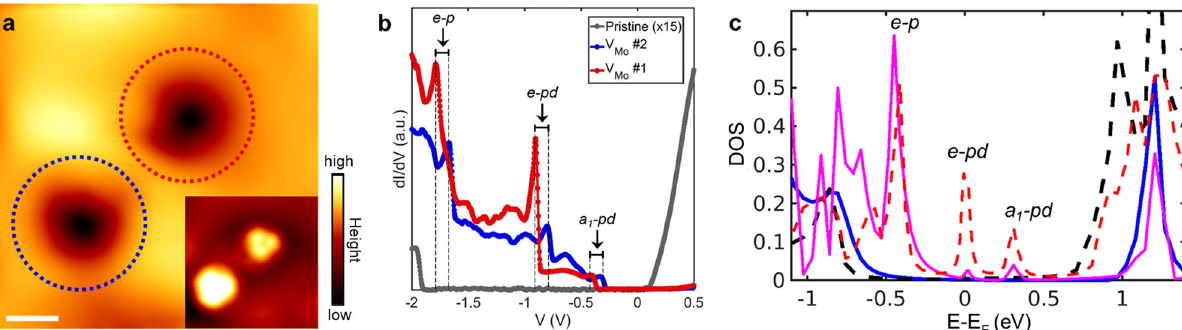
Fig. 2 Localized in-gap states exhibited by molybdenum vacancies. a STM topography zoomed in on the two primary defects shown in Fig.1b ( V set = 1.0 V, I set = 100 pA). The inset shows the same area acquired with V = − 2.0 V. Scale bar represents 1 nm. b STS acquired on top of the two defects in ( a ) where the red (blue) curve is acquired over the defect outlined with the red (blue) dashed circle ( V set = 1.0 V, I set = 100 pA) in ( a ). The gray curve is a spatially averaged d I /d V spectra acquired far from the defects on pristine MoS 2 . c The transmission coef fi cient t between the bottom Pb layer and the orbitals of S on a pristine overlayer (blue solid curve) and in the presence of a Mo defect (magenta solid curve). As a comparison, the corresponding PDOS spectra projected to the top sulfur layer are presented (black and red dashed lines for the pristine and defected case,